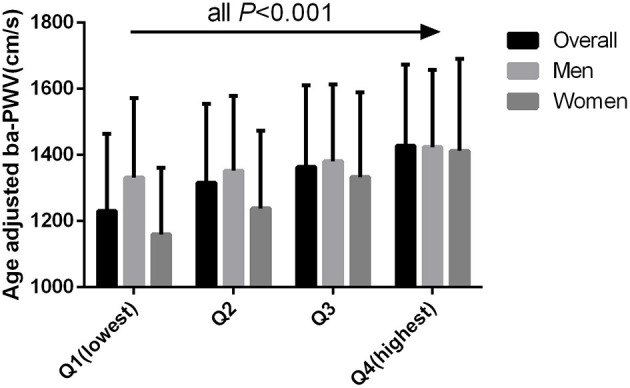
Age adjusted BaPWV compared across the TyG index quartiles for all participants, men, and women.